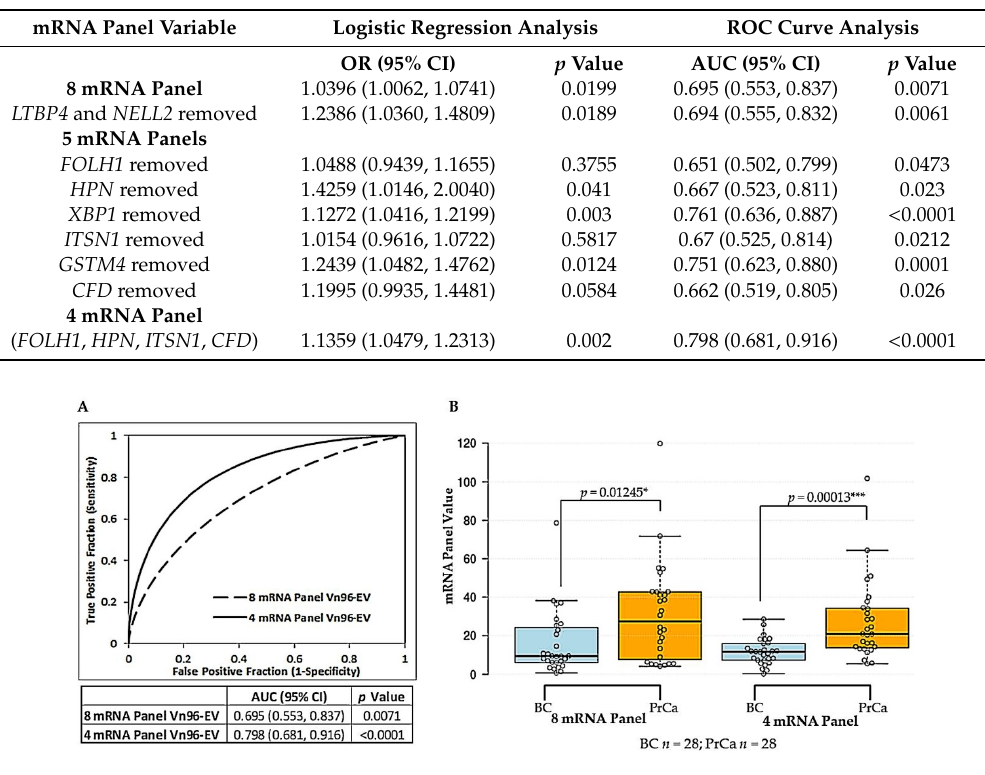
Figure 1. Comparison of Vn96-isolated EV reference-free eight mRNA versus four mRNA panels for prostate cancer discrimination. ( A ) ROC curve analysis showing discrimination of Prostate Cancer (PrCa; n = 28) from Benign Control (BC; n = 28) using either the eight mRNA or optimized four mRNA reference-free panel values obtained with Vn96-isolated EV RNA. AUC, 95% CI and p value are provided below the plot. ( B ) Box plot graphically depicting results of eight mRNA and four mRNA panels obtained for Benign Control (BC) versus Prostate Cancer (PrCa) groups using Vn96-isolated EV RNA. The central boxes represent the values from the lower to upper quartiles (25 th to 75 th percentiles). Lines within the boxes are the median values (50 th percentile). Whiskers extending from the boxes indicate the minimum to maximum values obtained (excluding outliers, which are displayed as separate points). p values were obtained using the Mann-Whitney U test to compare di ff erences. Di ff erences denoted by asterisks are statistically significant (* p < 0.05 and *** p < 0.001). Values for the eight mRNA panel were calculated as the ratio of expression of three mRNAs overexpressed in prostate cancer ( FOLH1 , XBP1 and HPN ) to five mRNAs underexpressed in prostate cancer ( ITSN1 , GSTM4 , LTBP4 , NELL2 , and CFD ). The optimized four mRNA panel used the ratio of expression of FOLH1 and HPN (over) to GSTM4 and CFD